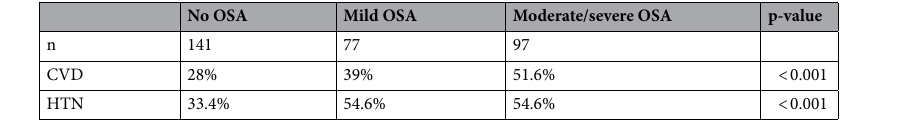
Table 1. Associate morbidity. CVD cardiovascular disease, HTN hypertension. p-value was determined by chi-square test.